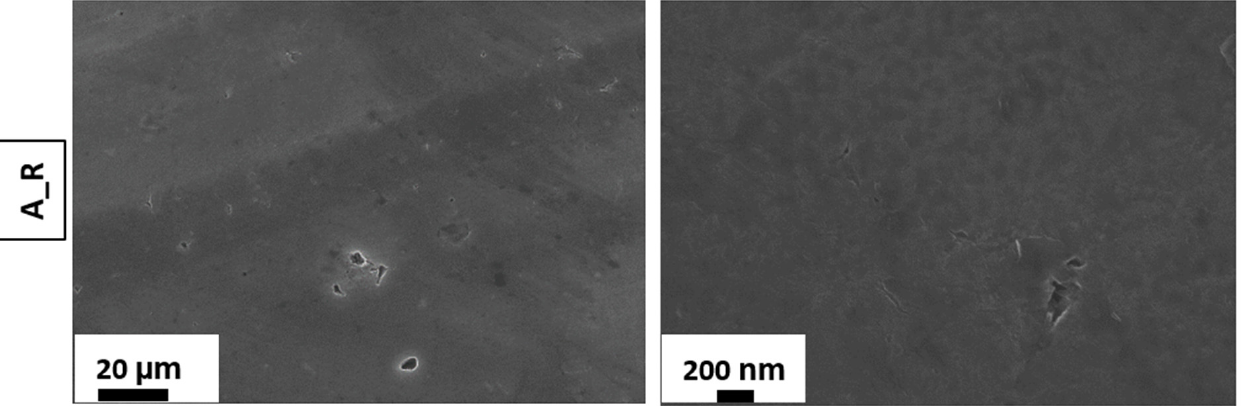
Figure 1. SEM images of the as-received sample.